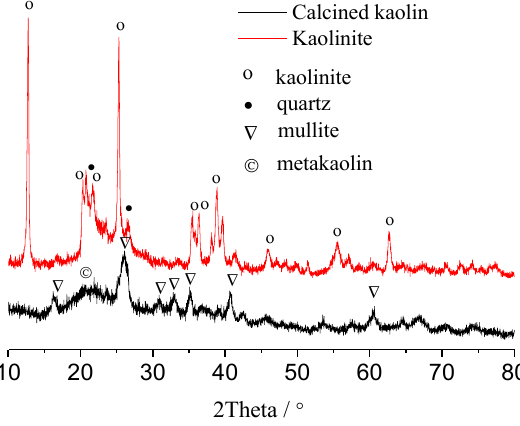
Figure 2. XRD patterns of kaolinite and